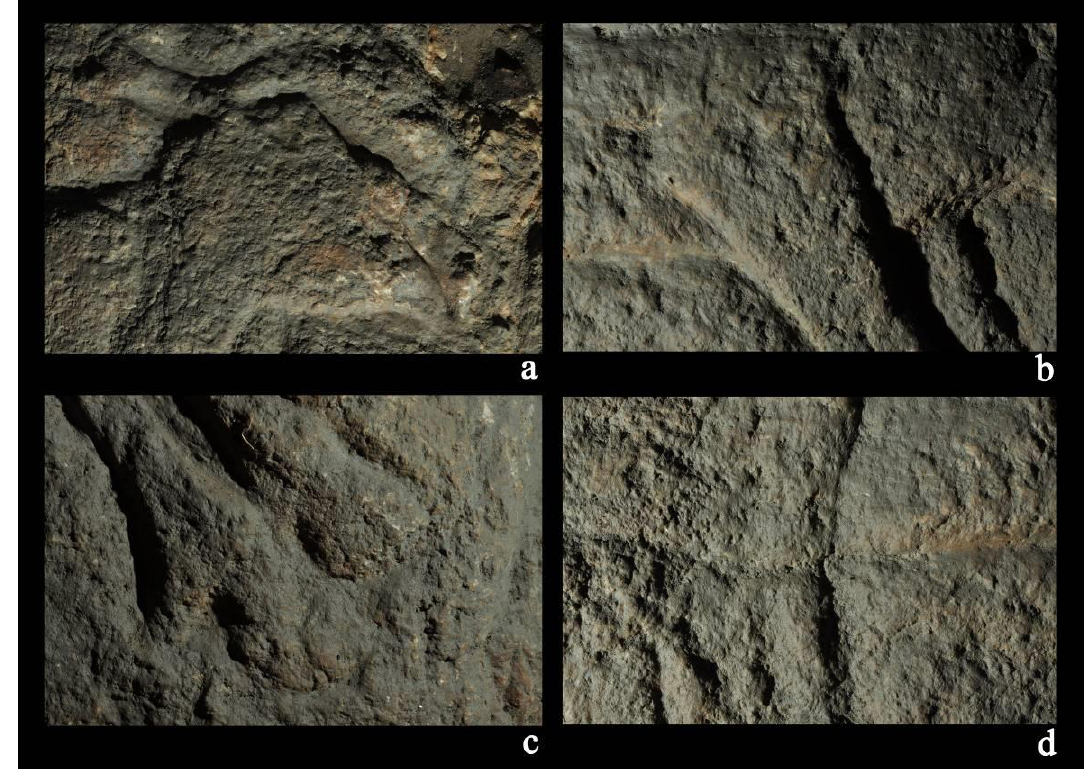
Figure. 12. Details of the figure of the large reindeer. a) Macro view of the head. The impacts on the level of the snout, which probably destroyed it, are easily visible. b) Differential relief of the front legs of the large reindeer. c) Detail of the cloven hooves of the front legs. d) Superposition of the line from the belly to the back leg of the first